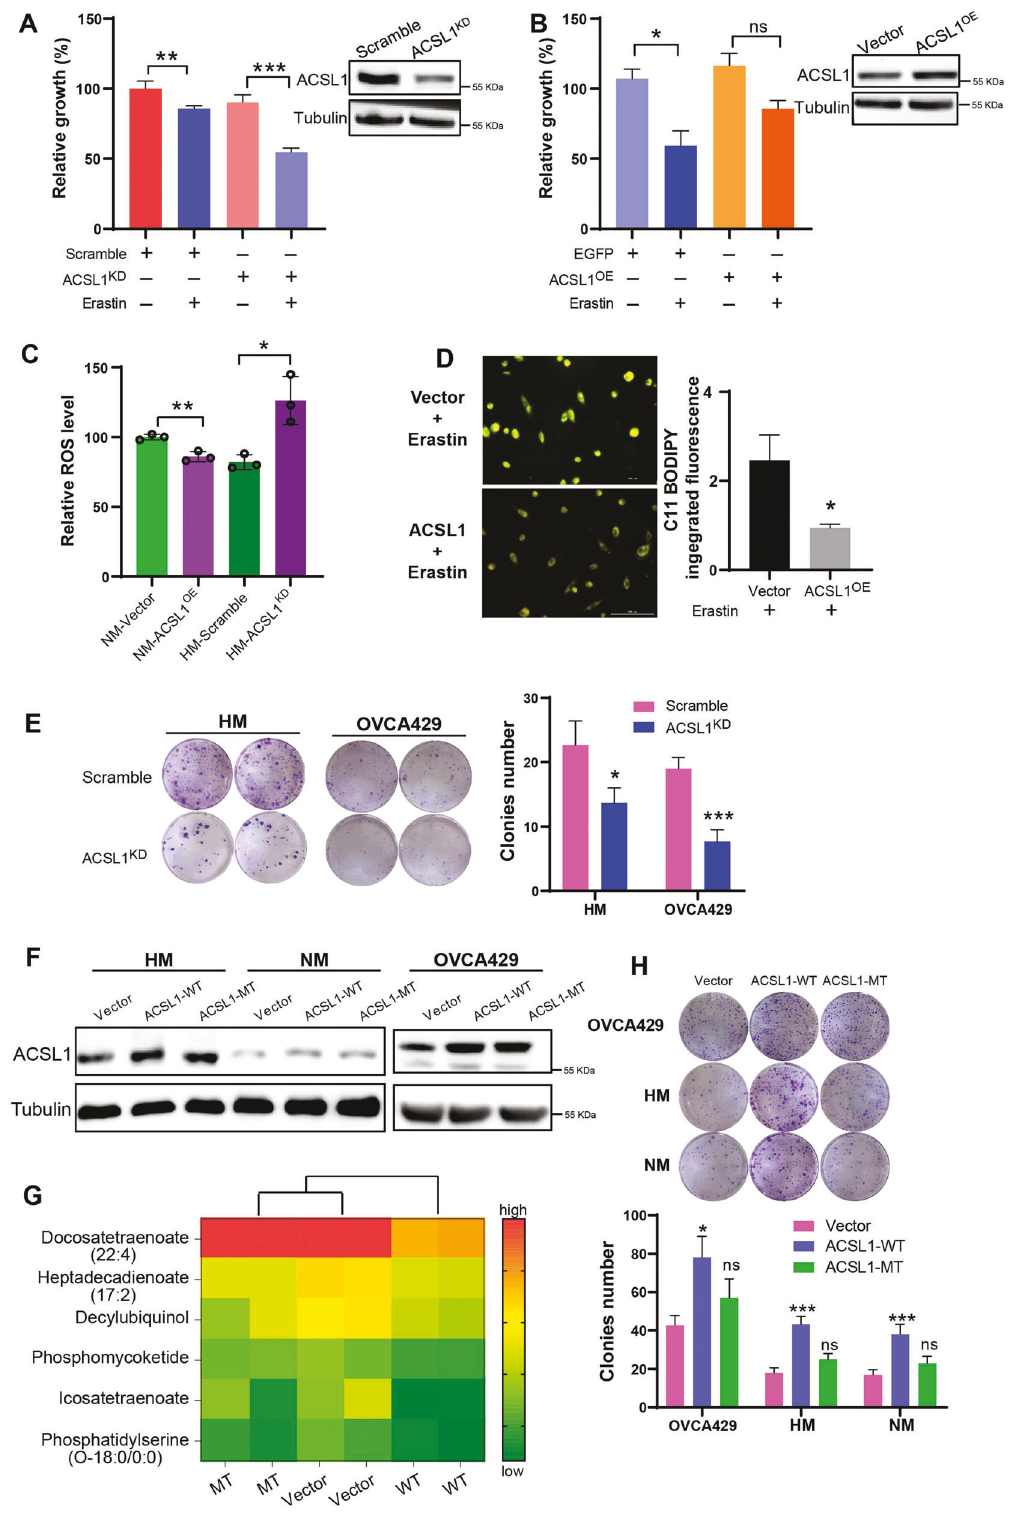
alignment with the overexpression data, the levels of FSP1 and SLC7A11 decreased in ACSL1 KD cells (Fig. 3B, D). GPX4 levels were partially up-regulated by ACSL1 overexpression in NM cells, but not in OVCA429 cells. However, ACSL1 knockdown only reduced the level of GPX4 in OVCA429 cells, but not in HM cells (Fig. 3D).